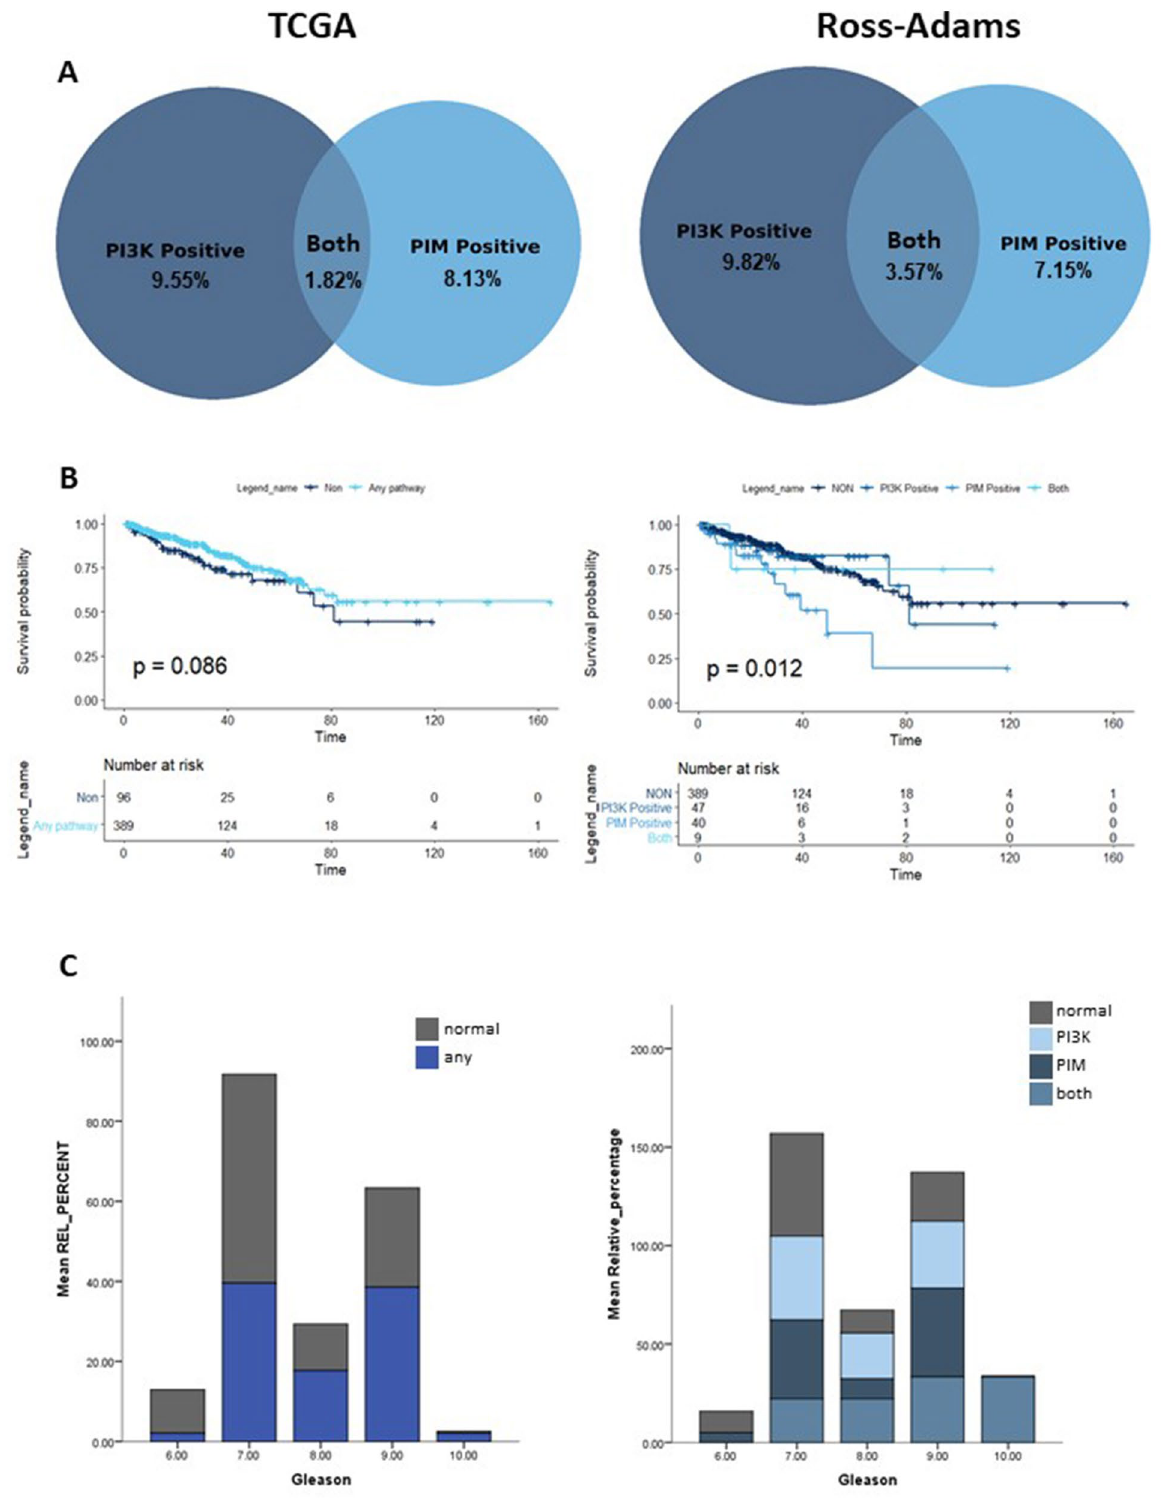
Figure 1. A high proportion of patients may be sensitive to PI3K/PIM inhibition. ( A ) Venn diagrams demonstrate the percentage of the prostate cancer cohort (TCGA or Ross-Adams, non-metastatic radical prostatectomy patients) that exhibited overexpression of the PI3K pathway, PIM pathway, or both. ( B ) Disease free survival probability of patients with any pathway upregulation versus no upregulation (left) and after separation into specific pathways (right). P-value was obtained using a Mantel-Cox test. ( C ) Distribution of Gleason grades within patient population groups. A higher Gleason score (1–5) indicates less well-differentiated prostate tissue and more aggressive disease. A Gleason grade is obtained by adding the Gleason scores of the two most prevalent tissue types in the sample. P-value was obtained using a Chi-square